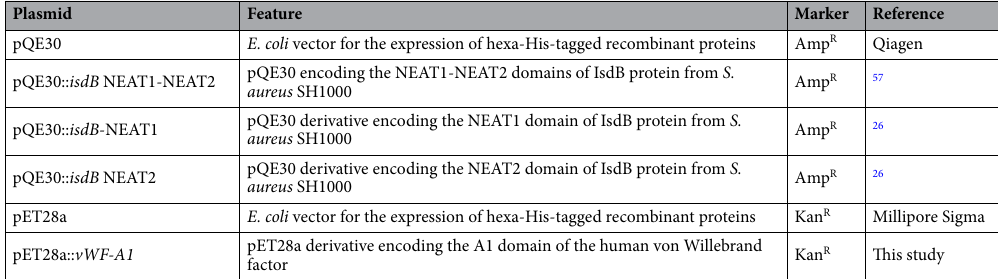
Table 2. Abbreviations used as follows: Amp R , ampicillin resistance; Kan R , kanamycin resistance.